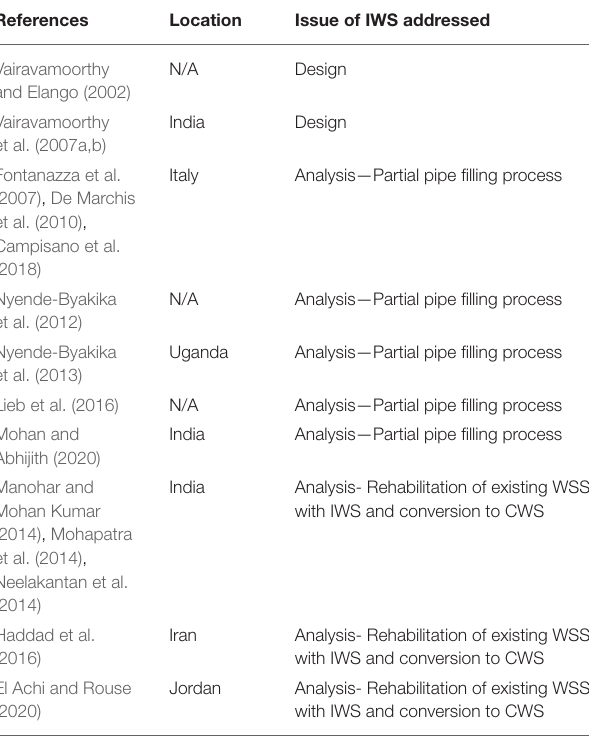
TABLE 3 | Studies contributing to design and analysis aspect of IWS. TABLE 4 | Studies contributing to operation aspect of